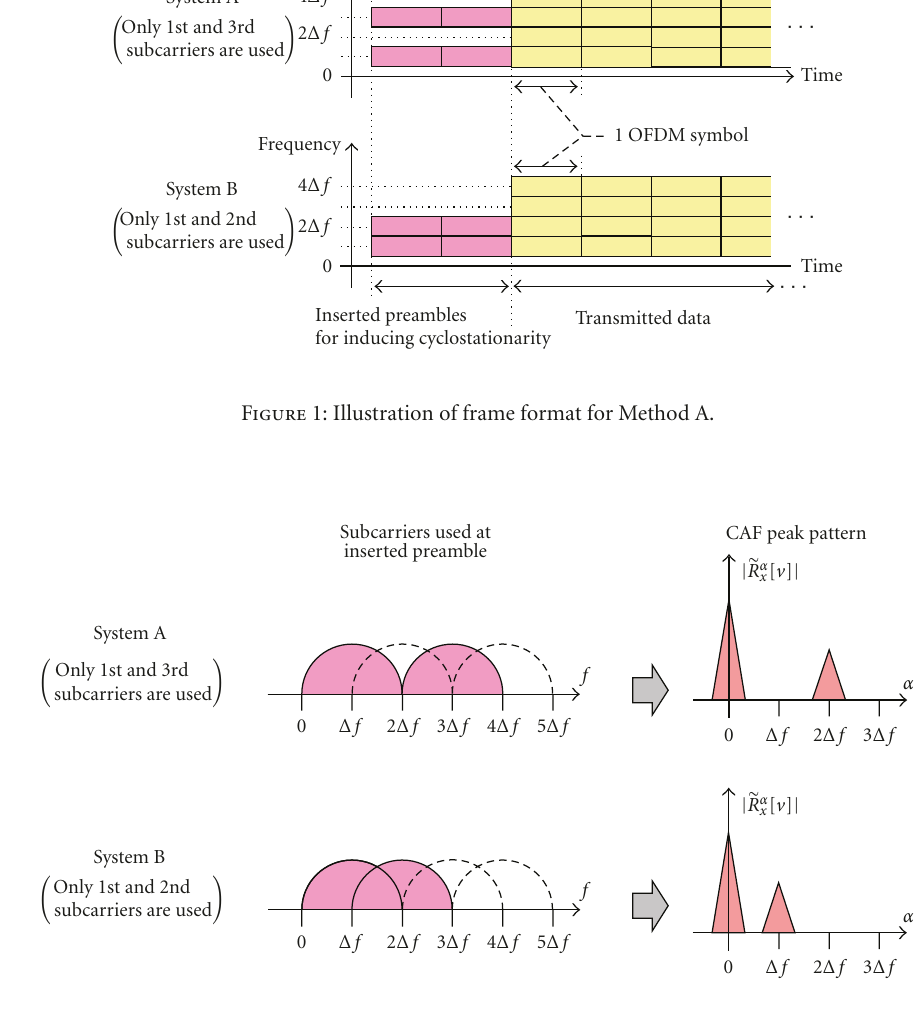
Figure 2: Examples of relation between subcarriers used at inserted preamble and CAF peak pattern ( ν = 0) for Method A.